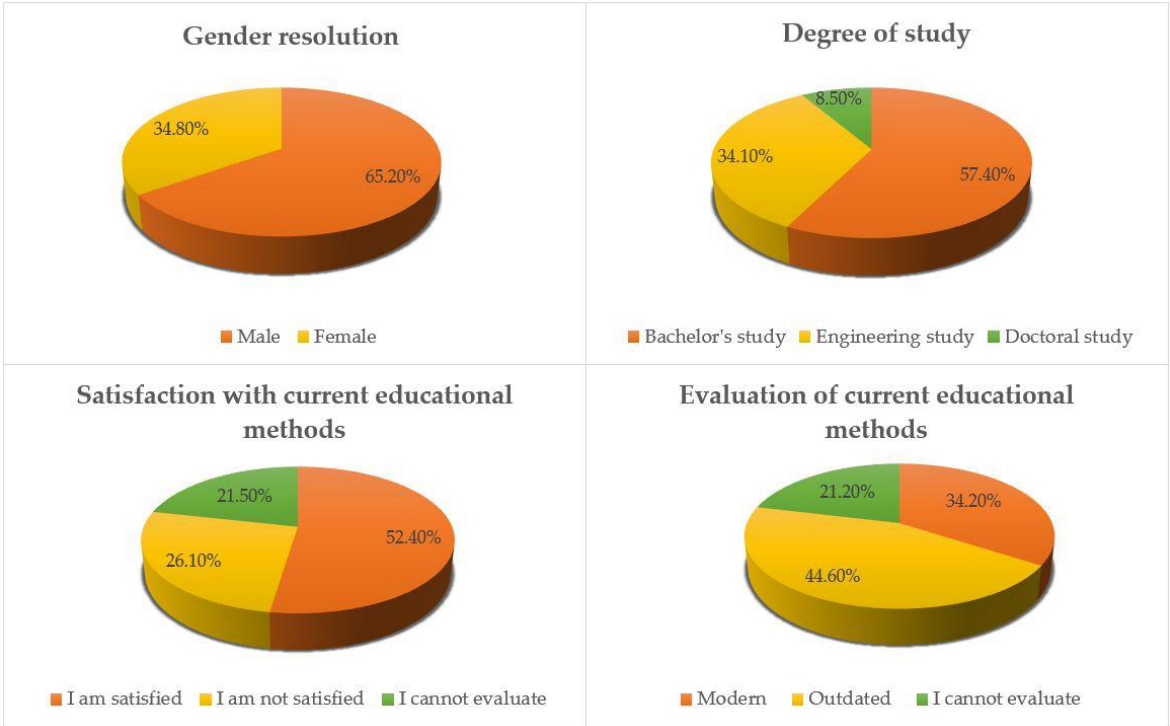
Figure 10. Graphical representation of students’ satisfaction with current teaching methods.